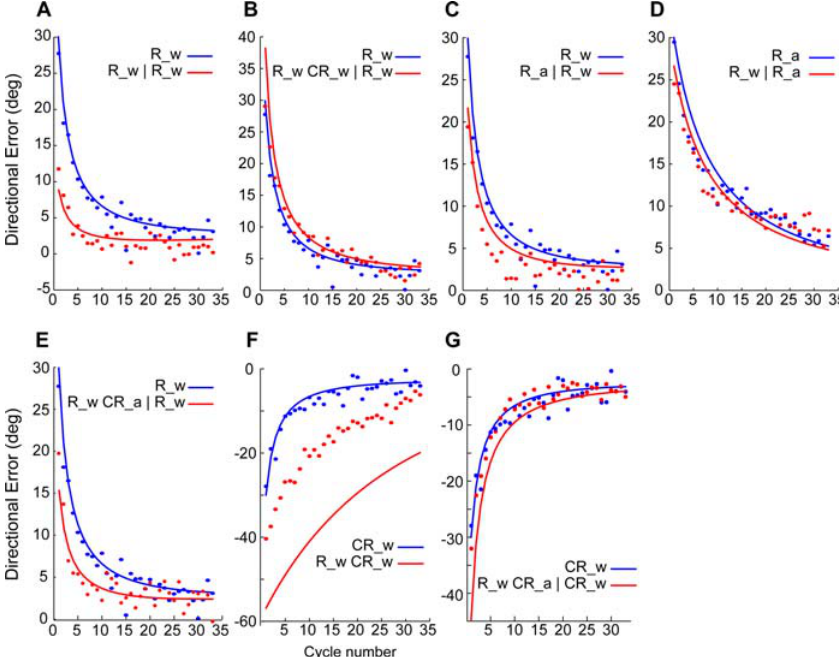
Figure 6. Simulation Results (Lines) along with the Measured Data (Dots) from All Experiments In the legend for each subplot, the vertical line refers to a 24-h break. (A) Savings from R wrist day 1 to R wrist day 2 (experiment 1). (B) Catastrophic interference when R wrist on day 1 is followed by CR wrist on day 1 and R wrist is relearned on day 2 (experiment 1). (C) R arm transfers to R wrist (experiment 2). (D) Learning R arm is slower than R wrist , and R wrist shows little transfer to R arm (experiment 2). (E) Prior learning of R wrist blocks interference by CR arm (experiment 3). (F) Learning of R wrist interferes anterograde with CR wrist learned 5 min later (experiment 3). (G) Prior learing of R wrist blocks transfer of CR arm to CR wrist (experiment 4). DOI: